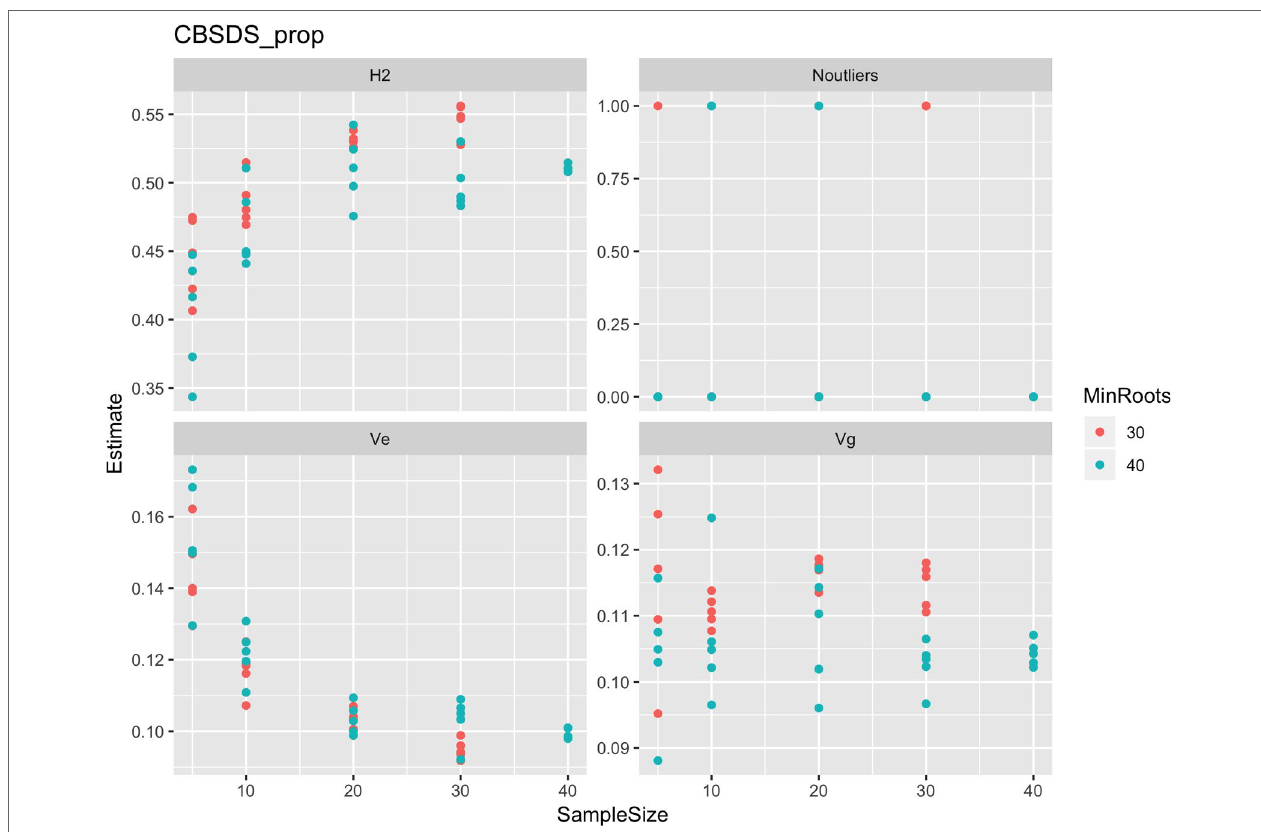
FiGURe 7 | Influence of root sample sizes on proportion-based root necrosis index (CBSD-proportion). H 2 , broad-sense heritability; Ve, error variance component; Vg, genetic variance component; Noutliers, number of outliers. Analysis based on resampling of 5, 10, 20, 30, or 40 roots from each plot at random.